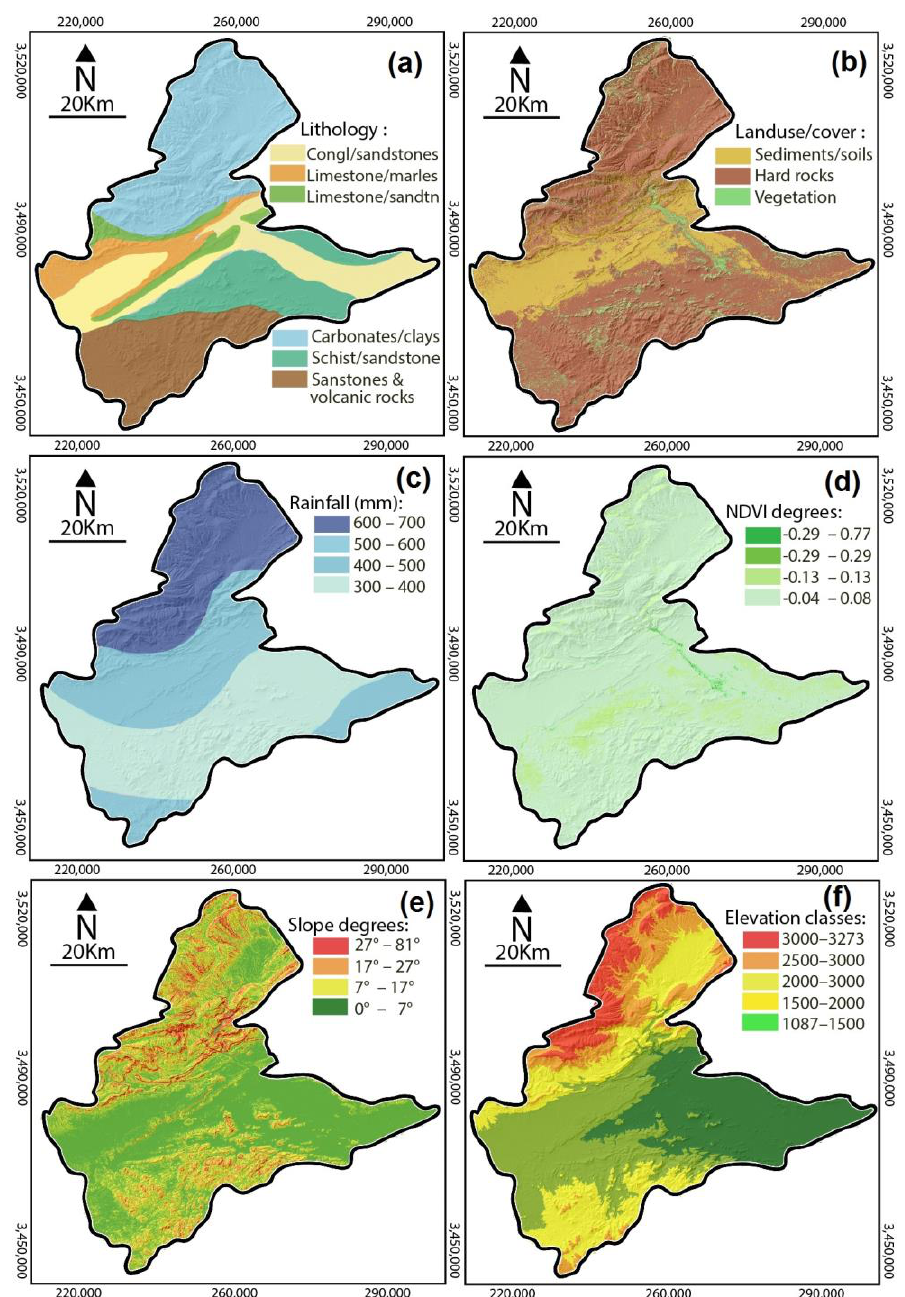
Figure 4. Causal factors of the erosion involved: ( a ) lithological units, ( b ) land use, ( c ) rainfall, ( d ) NDVI, ( e ) slopes, and ( f ) elevations.